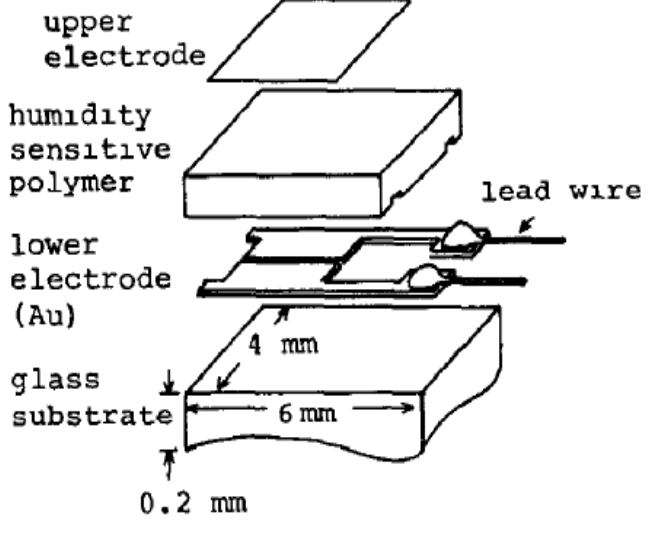
Figure 10. Configuration of ‗Humicape‘ humidity